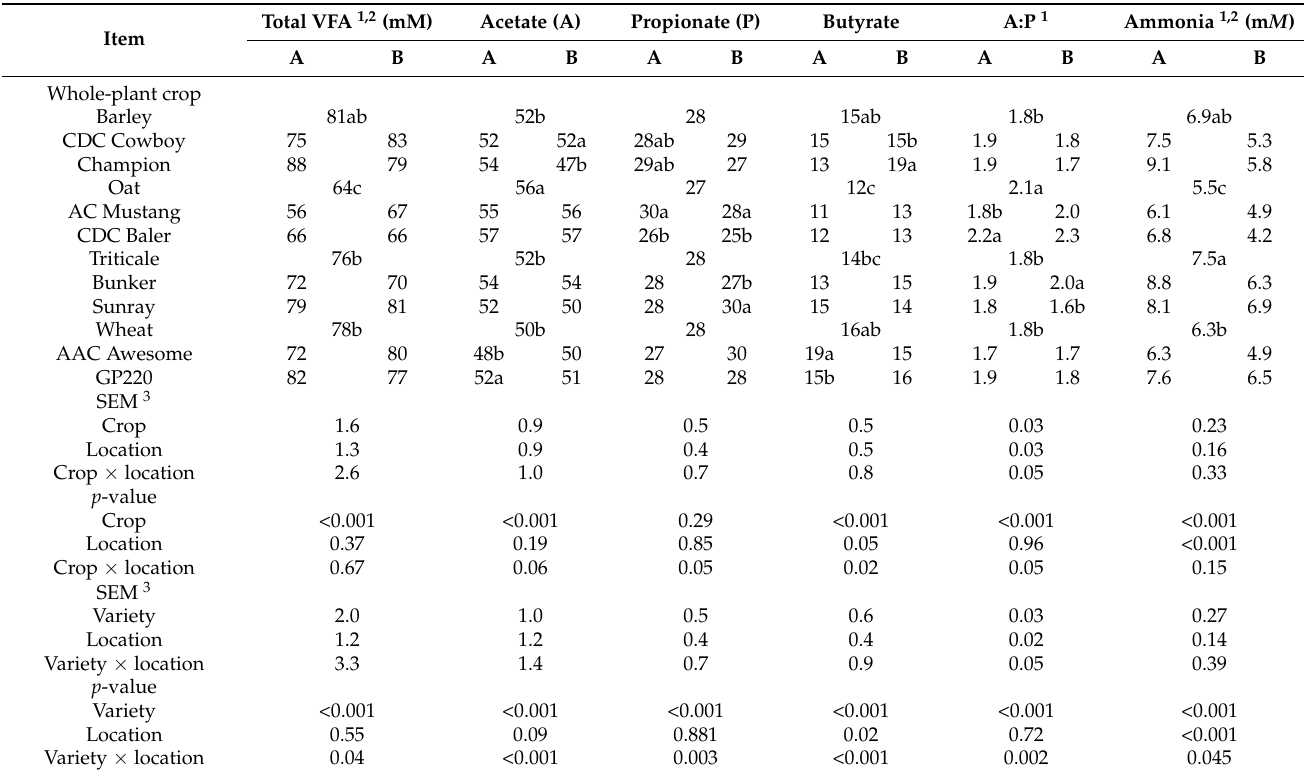
Table 3. In vitro total volatile fatty acid (VFA) concentration and individual VFA proportions of whole-plant cereal crops grown and harvested at two locations (A, B) in central Alberta.